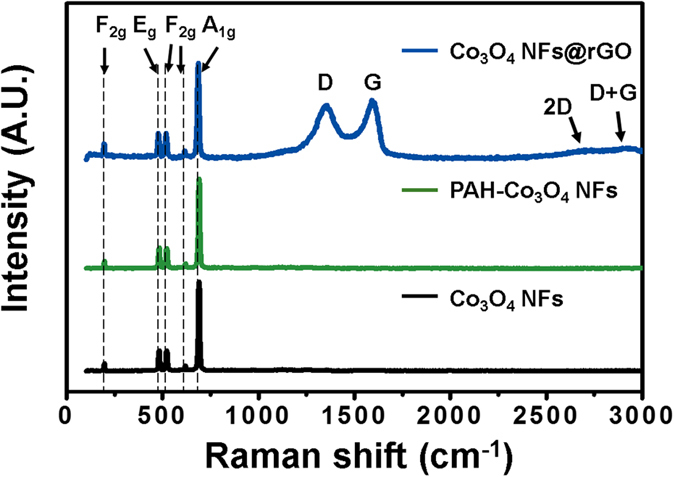
Raman spectra of Co3O4 NFs@rGO, PAH-treated Co3O4 NFs and Co3O4 NFs.